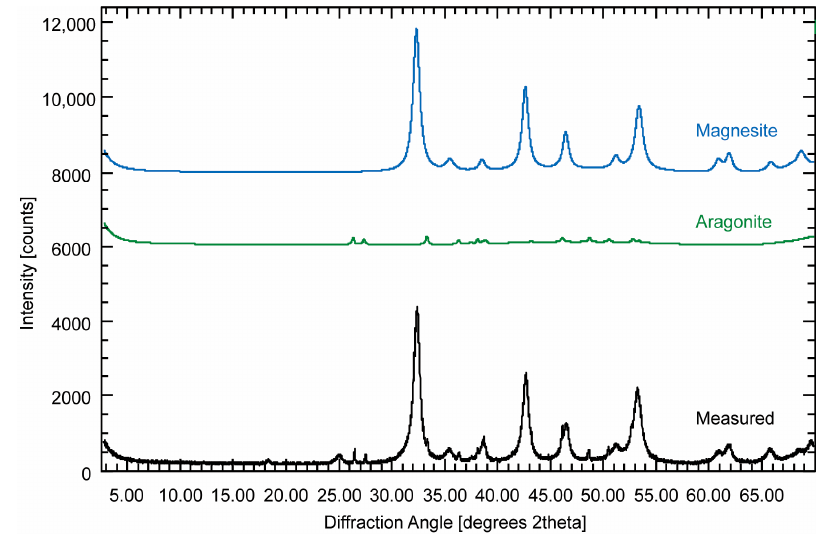
Figure 8. Powder X-ray diffractogram of the reaction product after 36 cycles at the end of the experiment for the second (with zinc ions) series of pH cycling experiments, with the Rietveld refined fit for aragonite and magnesite (each indicated by a different colour) used for quantification of the relative mineral contents.